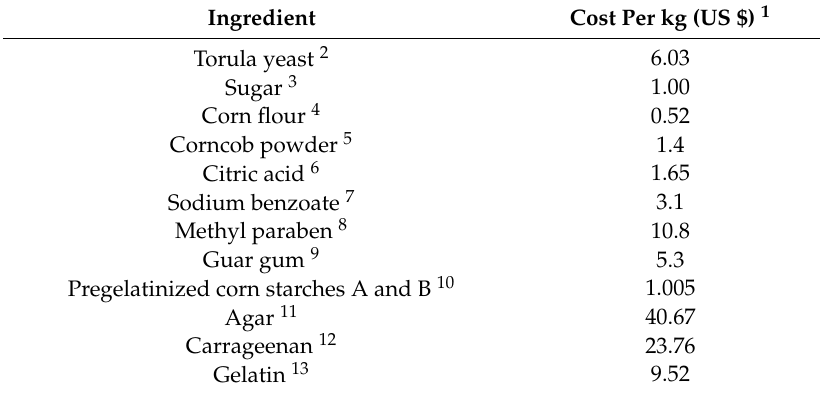
Table 1. Costs per kg and suppliers of the ingredients used in experimental